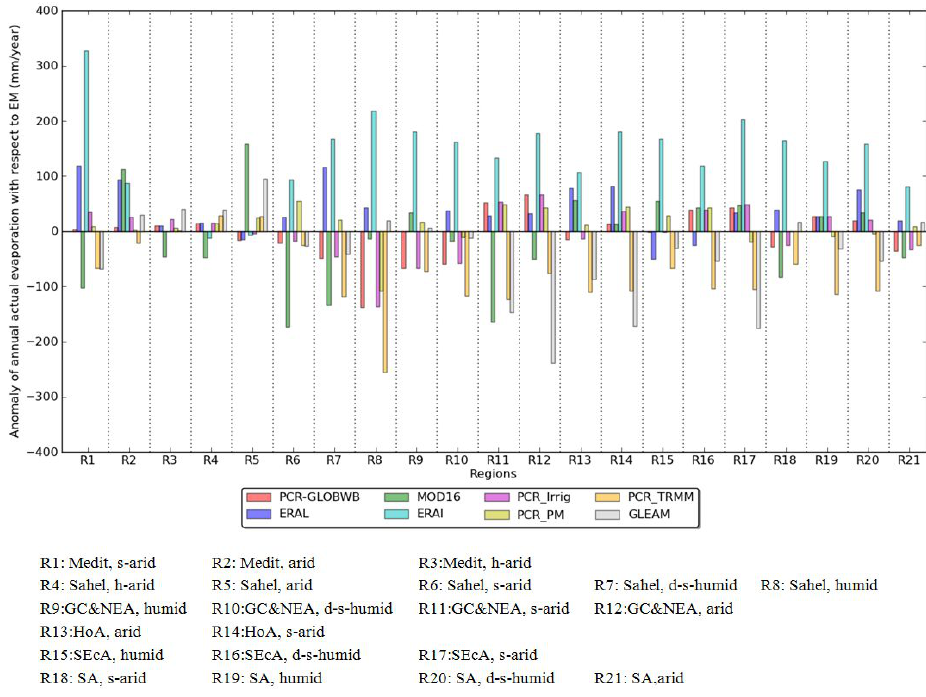
Fig. 6. Annual anomaly of evaporation for each product with respect to the evaporation multiproduct (EM) for each region.